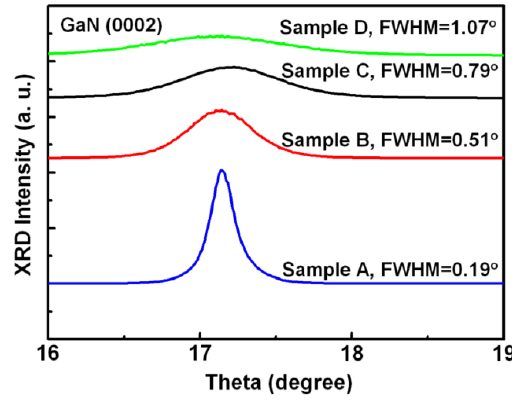
Figure 2. X ‐ ray diffraction (XRD) measurements results of GaN films grown on different substrates.